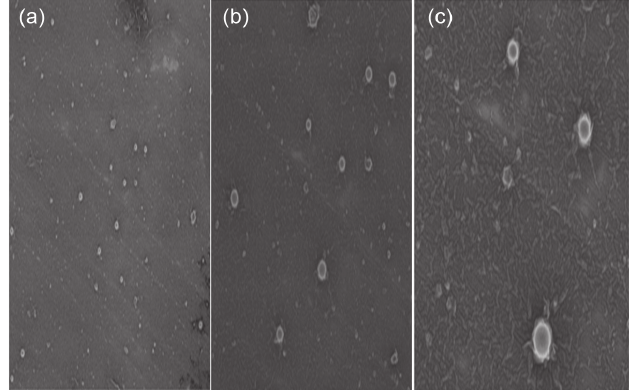
FIGURE 3 - Representative SEM photographs Nifedipine self-nanoemulsifying system (a) 1000_ magnification, (b) 2500_magnification and (c)